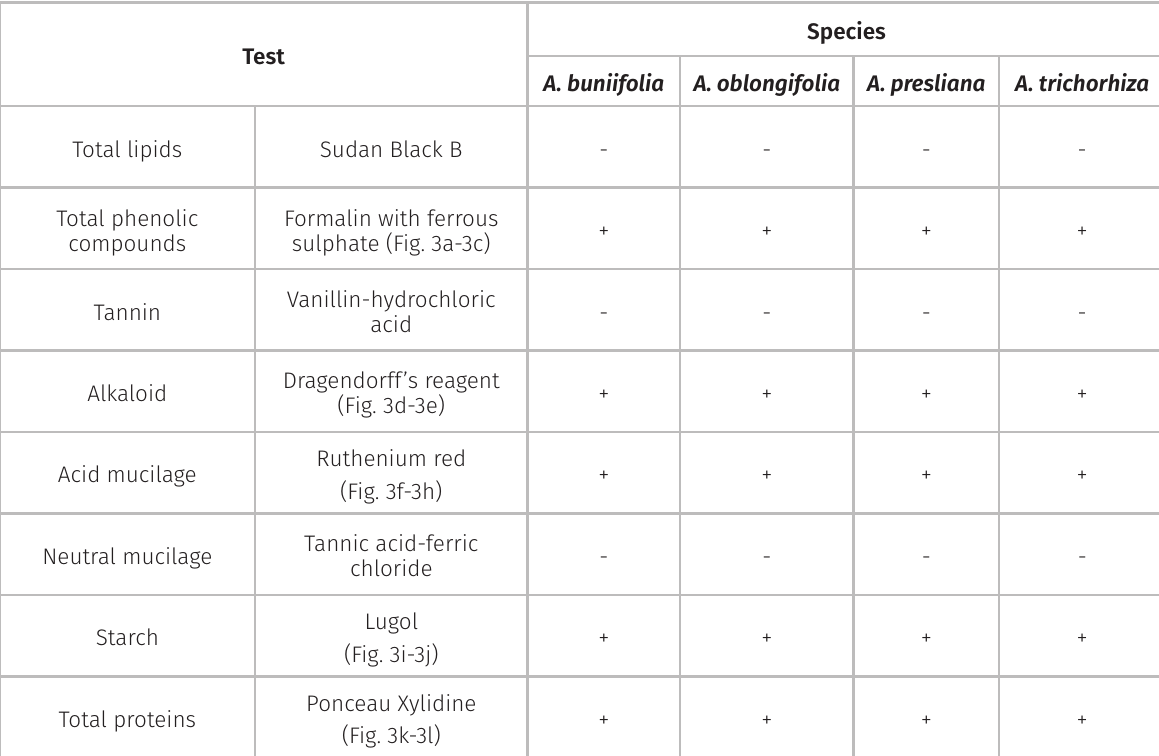
Table III. Results of histochemical tests applied to the secretion of leaf structures present in Anemia species. Notes: (+) positive result; (-) negative